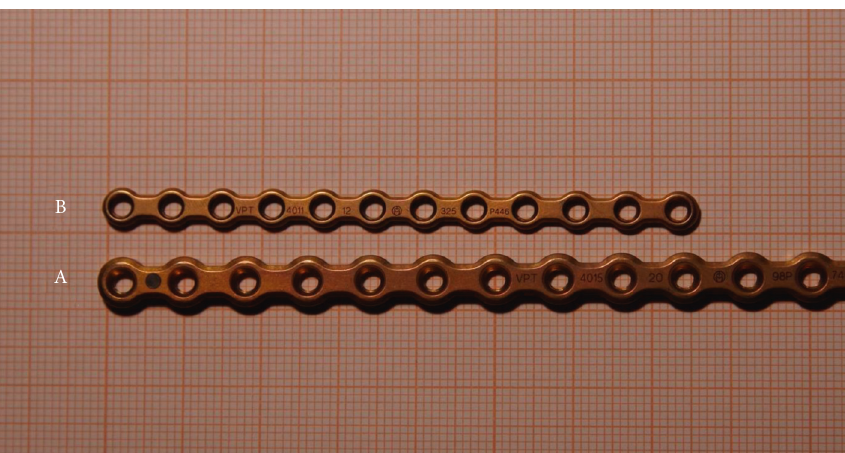
Figure 2: Two different 2-0 UniLock osteosynthesis plates used in the study. (A) 1.5mm thick plates with an 8 mm interhole distance. (B) 1.3mm thick plates with a 6.5mm interhole